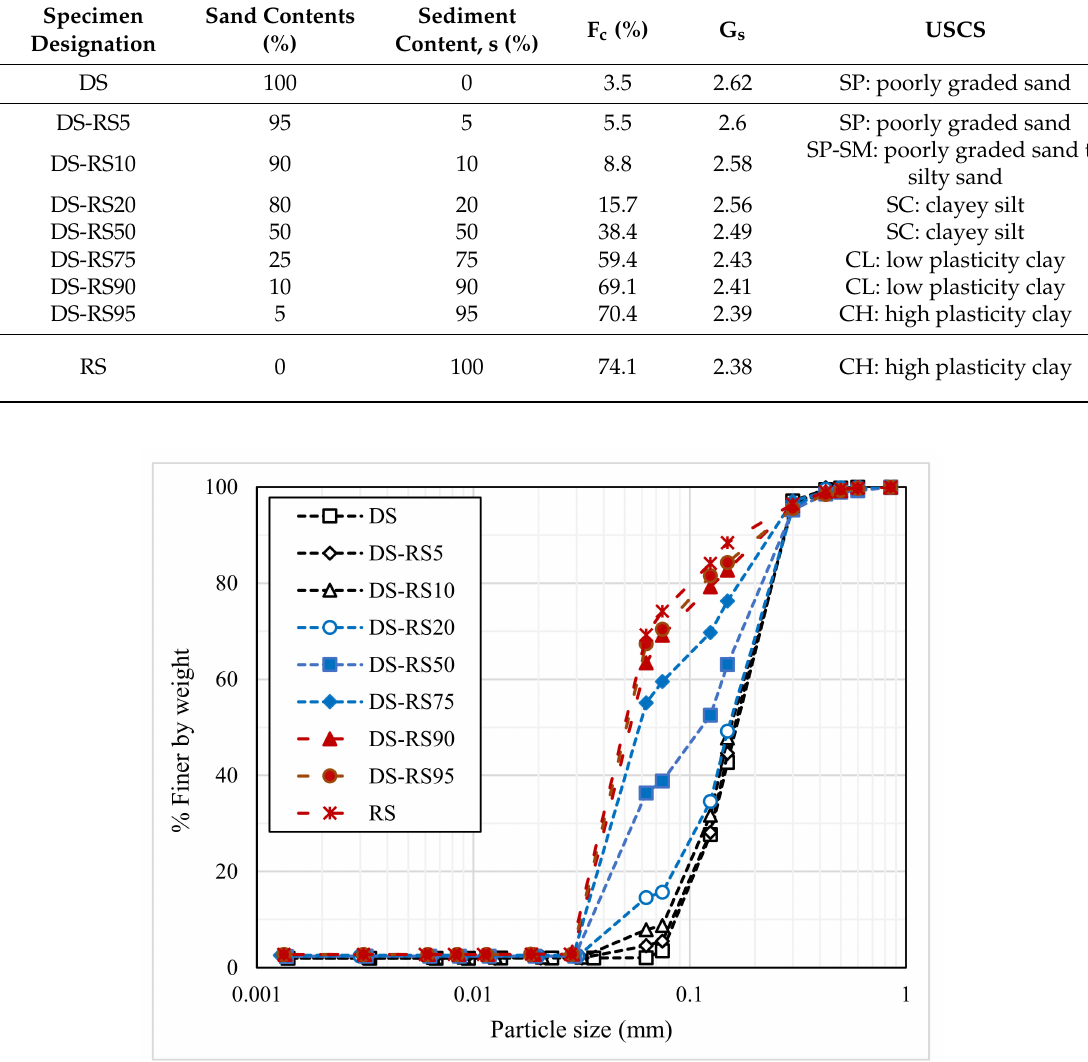
Table 2. Index properties of dune sand–reservoir sediment mixtures.